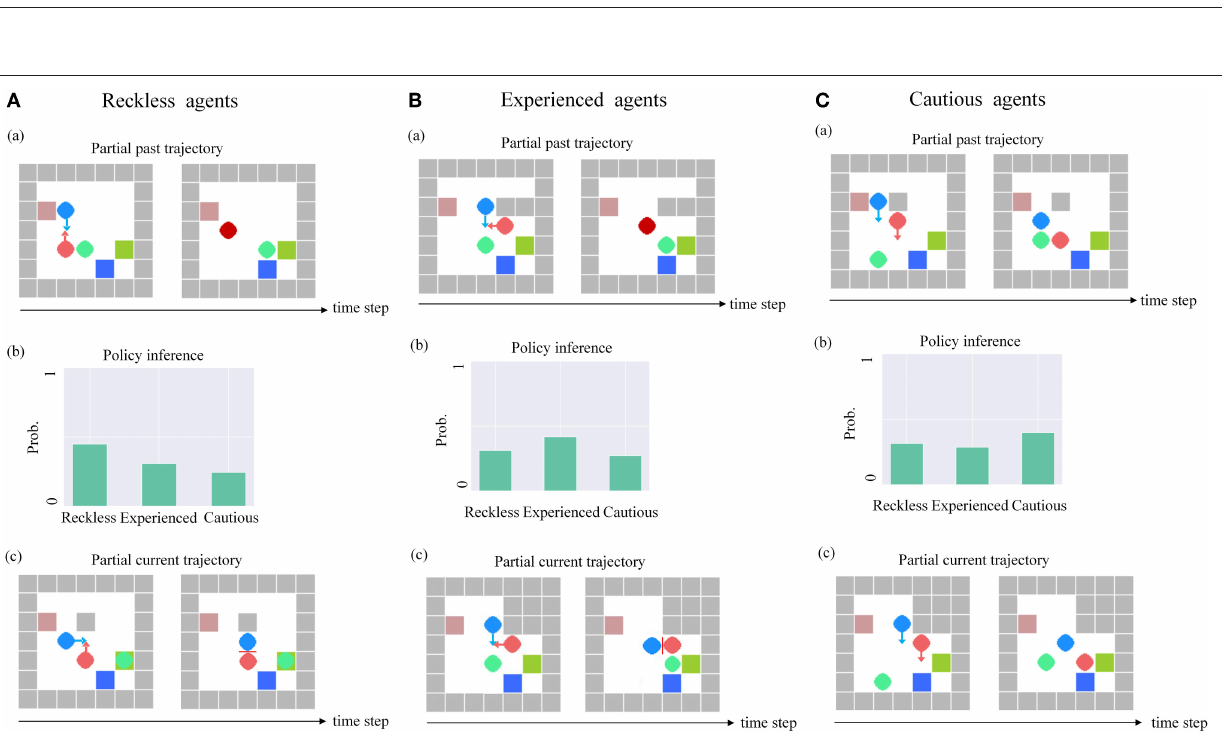
FIGURE 7 | The ToM-SNN model on three kinds of agents in random environments. (A) The bystander with the ToM-SNN model’s prediction of pedestrian 2’s policy characteristic based on the partial past trajectory [e.g., A (a)] is shown in A (b). In another environment, the bystander with the ToM-SNN model can predict the risks of pedestrian 2 and help it to avoid risks. (B) The bystander with the ToM-SNN model predicts that pedestrian 2’s policy characteristic is experienced based on the partial past trajectory [e.g., B (a)] is shown in Figure. In another environment, the bystander with the ToM-SNN model can predict the risks of pedestrian 2 and help it to avoid risks. (C) The bystander with the ToM-SNN model predicts that pedestrian 2 is a cautious agent shown in C (b) based on the partial past trajectory [e.g., C (a)]. In another environment, the bystander with the ToM-SNN model did not interfere with pedestrian 2 ’s action because it evaluated pedestrian 2’s next state was safe [ C